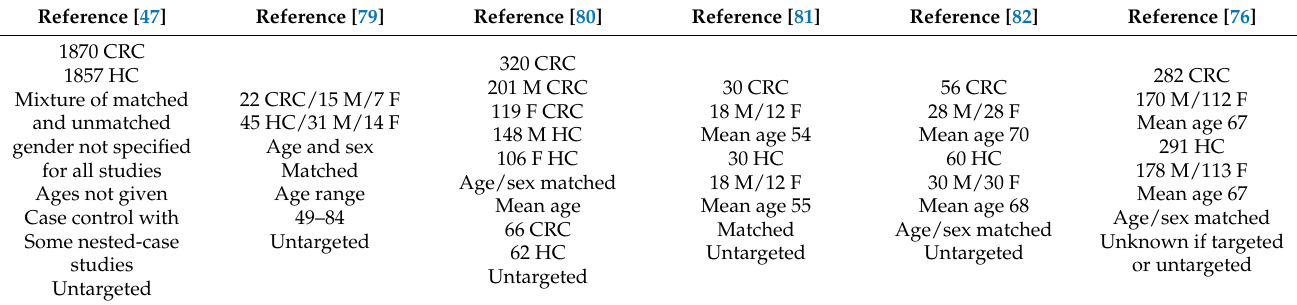
Table 7. Description of patient cohorts and study types used in CRC studies.